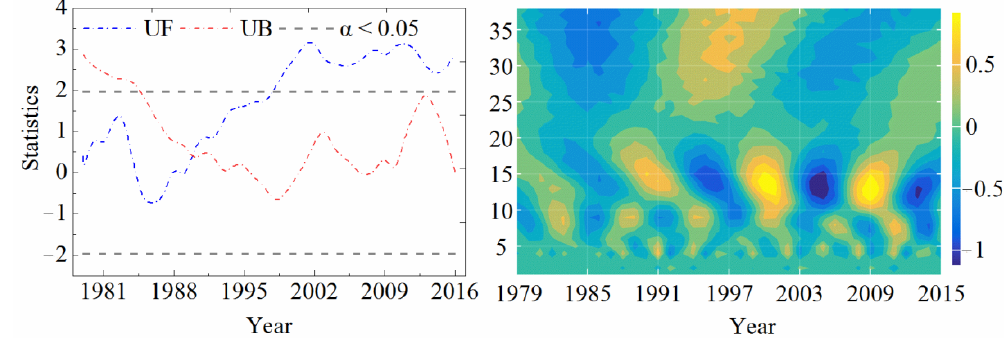
Figure 5. Mutation test analysis and wavelet analysis of the runoff series in the Yushugou Basin from 1979 to 2016.